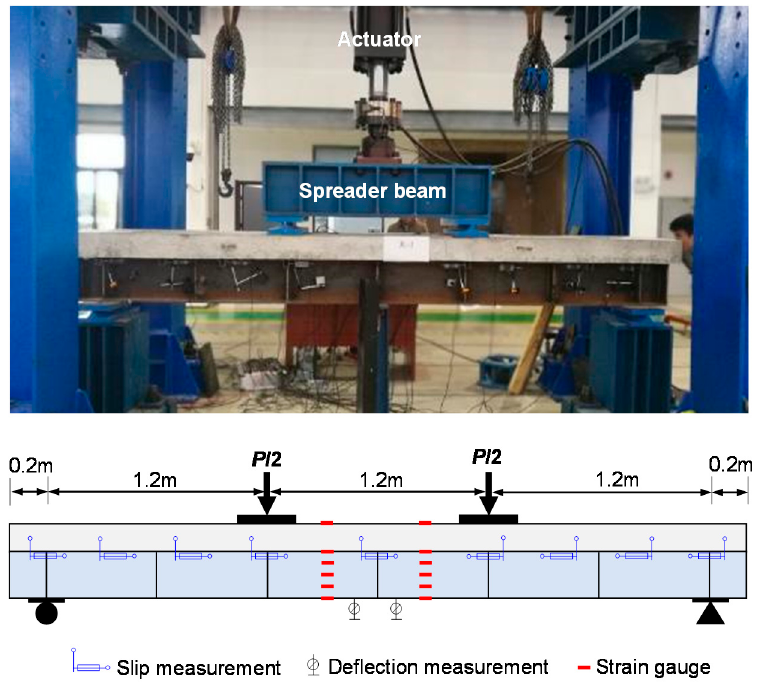
Figure 6. Test set-up and instrumentation of composite beam specimens.